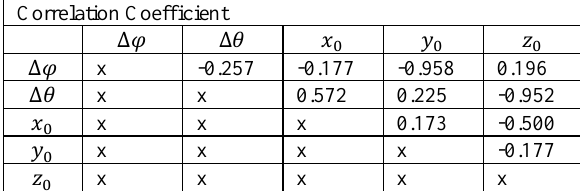
Table 1. Estimate precision of two type of scan